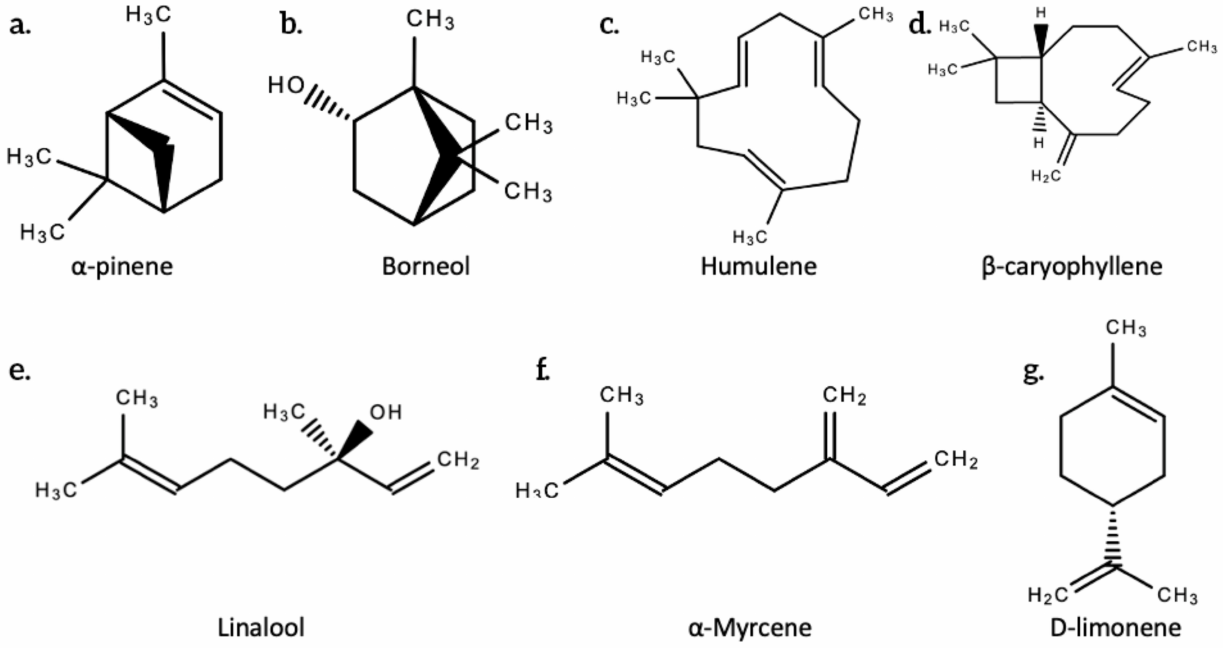
Figure 2. The chemical structures of some terpenoids produced by Cannabis sativa L. ( a .) α -pinene; ( b .) Borneol; ( c .) Humulene; ( d .) β -caryophyllene; ( e .) Linalool; ( f .) α -Myrcene; ( g .)